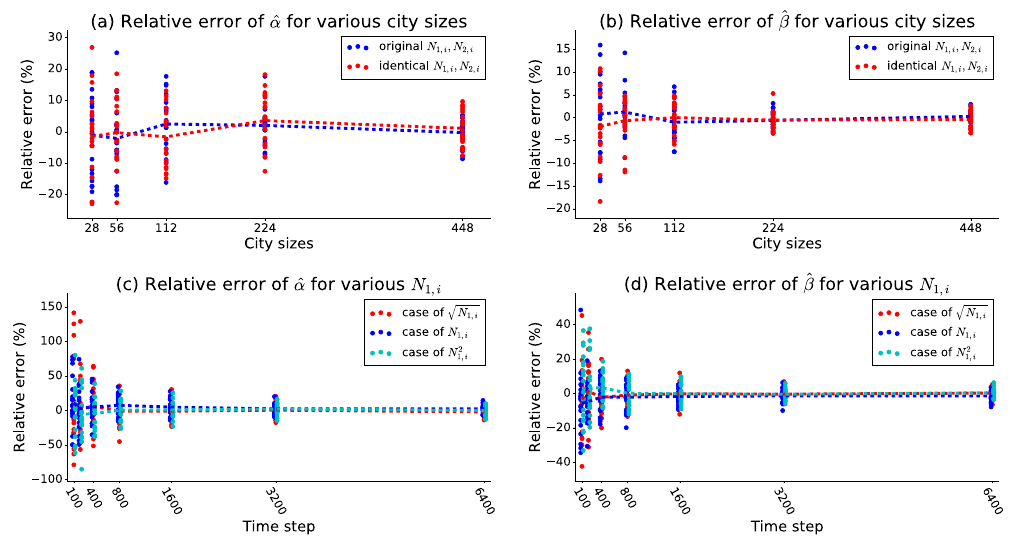
Figure 5. Parameter recovery in various scenarios. ( a , b ) show relative errors of recovered α ˆ and β ˆ for five city sizes: 28, 56, 112, 224 and 448. Blue color represents the city with three types of houses and different values of N 1, i and N 2, i . Red color represents the city with identical value of N 1, i and N 2, i . The dashed curve shows the mean values of relative error over 20 realizations and each dot represents one realization. The length of historical dataset is 1600. Parameter values are shown in Table 1. ( c , d ) show relative errors of recovered α ˆ and β ˆ for three cases of N 1, i . Red dots represent the case of N , blue represents the case of N 1, i , and cyan represents the case of i 1, N i 1,2 . The results come from 20 independent realizations and 6 different lengths of historical dataset: 100, 400, 800, 1600, 3200 and 6400. N 1, i is 0.4 for large 0.3 for medium and 0.2 for small houses. α = 0.08, β = 0.012, γ = 0.016 and δ =